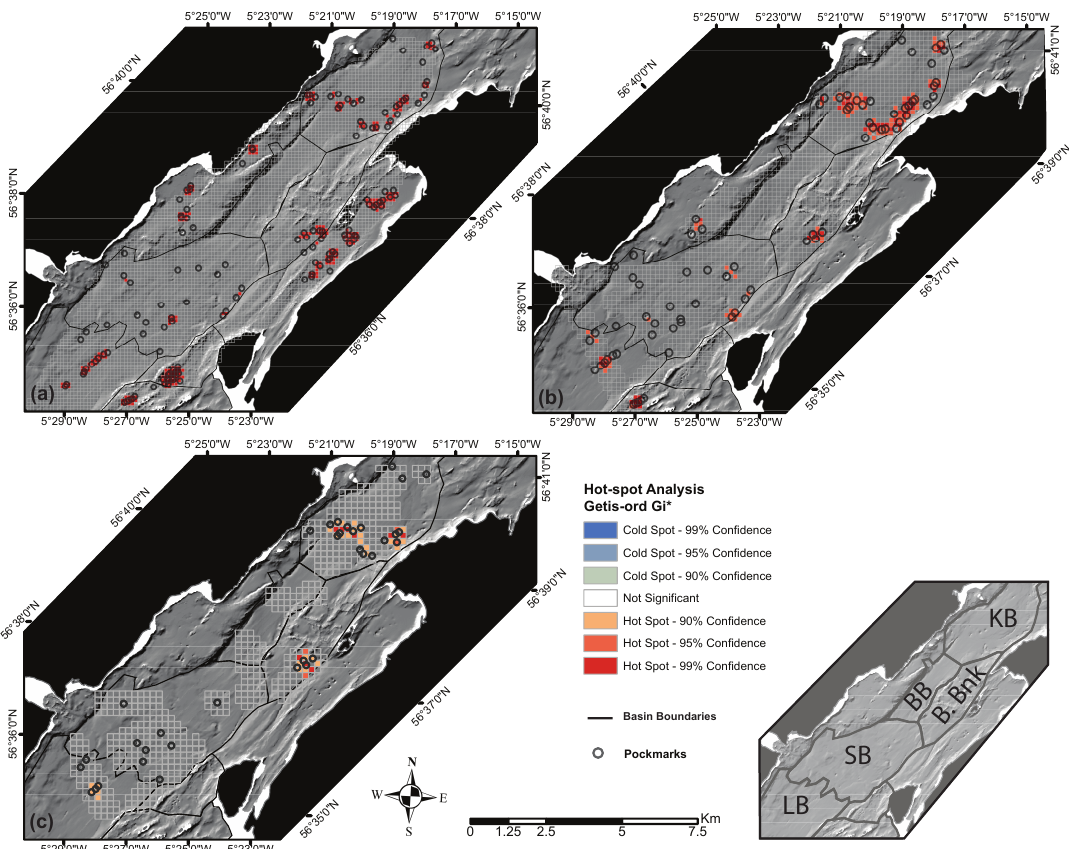
Figure 2. Hot-spot analysis using the Getis-ord Gi* statistic of pockmarks within Loch Linnhe along with an inset map showing main basins mentioned in Figure 1; ( a ) hot-spot analysis of all pockmarks within Loch Linnhe; ( b ) hot-spot analysis of pockmarks that occur within the region of the boomer seismic survey; ( c ) hot-spot analysis of pockmarks where gas was observed in seismic